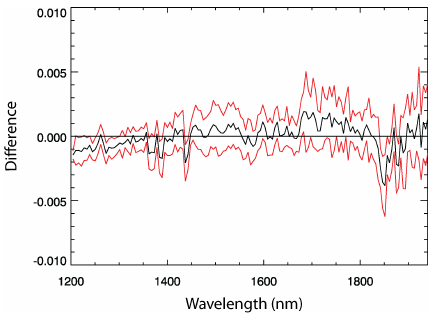
Figure 9. The mean (black) and standard deviation (red) difference (MODTRAN minus SSFR) spectra are plotted for the 11